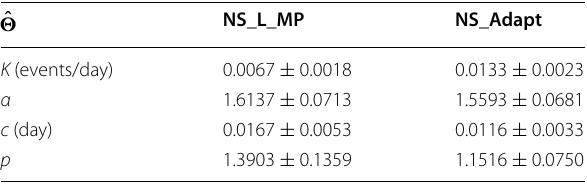
Table 2 Estimates of the ETAS model aftershock parame- ˆ (cid:31) ters ( ) for the earthquake occurrences in Gisborne region